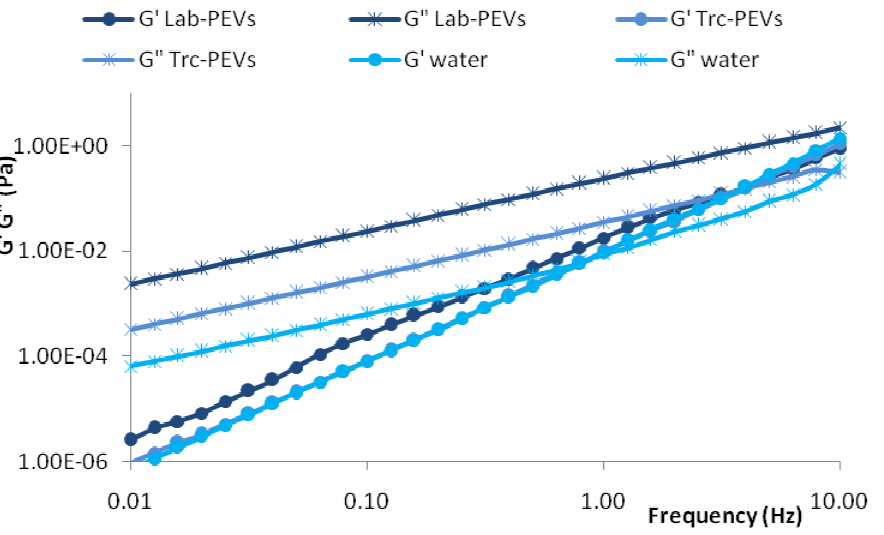
Figure 3. Frequency sweep spectra for PEVs: storage (G’) and loss (G”) moduli against frequency are